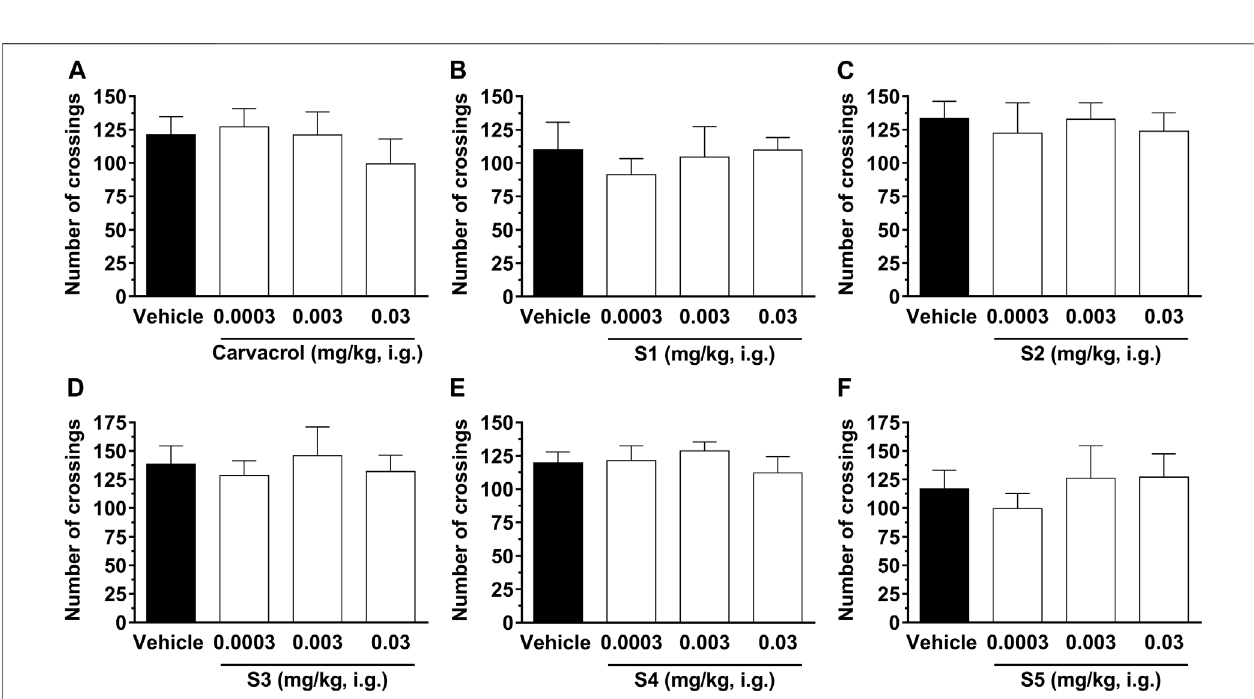
FIGURE 6 | Effect of compounds on the spontaneous locomotion of animals. The crossings were evaluated 1 h after treatment with carvacrol (A) , S1 (B) , S2 (C) , S3(D) , S4(E) and S5(F) atdosesrangingfrom0.0003,0.003,and0.03 mg/kg,i.g.,(openbars)orvehicle/control(closedbar).Eachbardenotestheaveragevaluesfor 6 – 8 animals, and the vertical lines represent SD. One-way ANOVA and Dunnett test for multiple comparisons were used to determine the statistical signi fi cance.